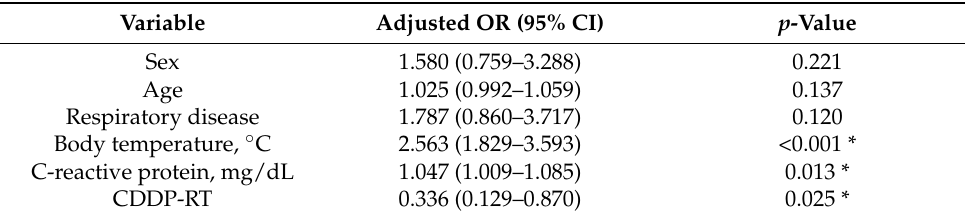
Table 2. Factors independently associated with bloodstream infections in patients with head and neck